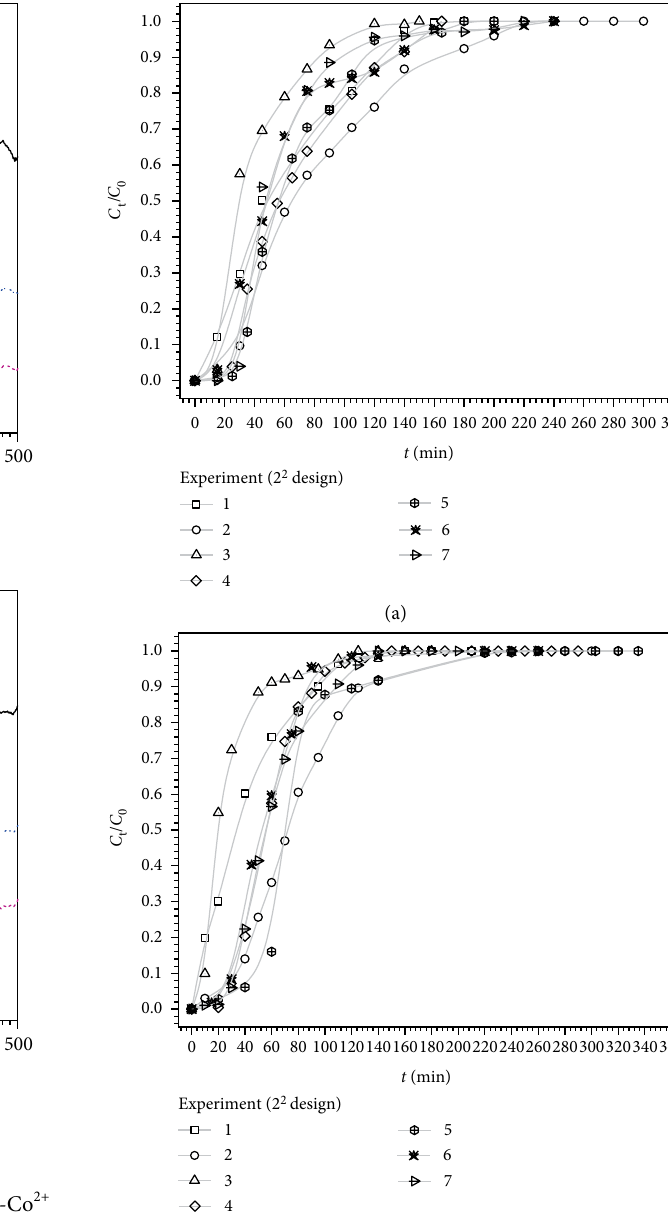
Figure 5: Breakthrough curves for adsorption of (a) Cu 2+ and (b) Co 2+ on SBox adsorbent in a fixed-bed column at 25°C (experiments from 1 to 7 refers to the 2 2 experimental design matrices for Cu 2+ and Co 2+ presented in Tables 1 and